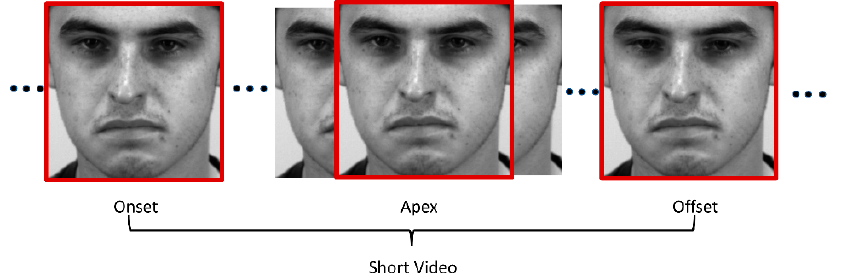
Figure 1. ME short video.